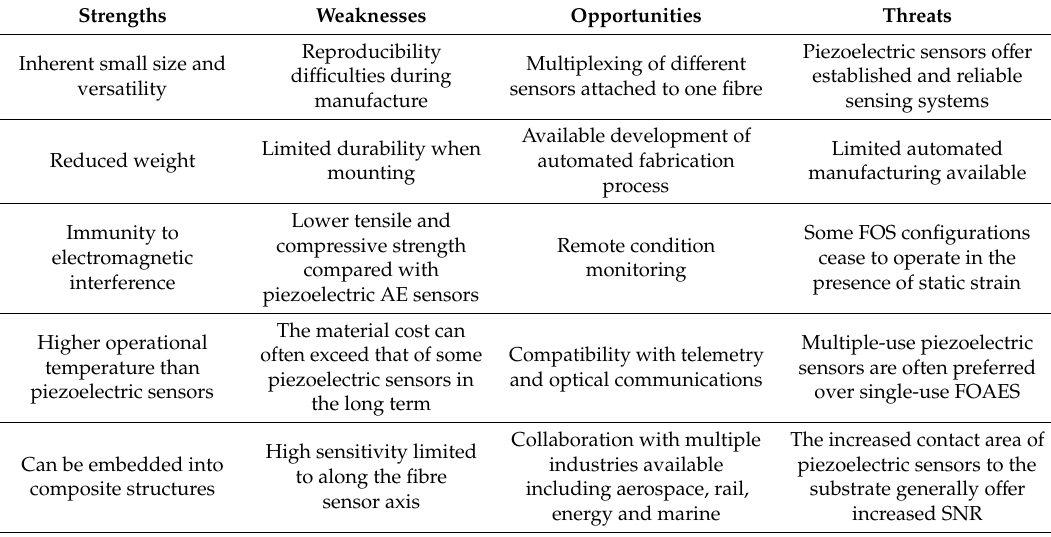
Table 2. A brief SWOT analysis of